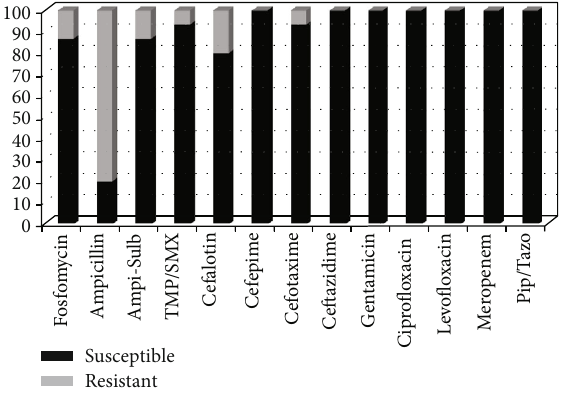
Figure 3: Percentage of Klebsiella pneumoniae isolates susceptible to antimicrobial drug. TMP/SMX: trimethoprim/sulfamethoxazole; Ampi-Sulb: ampicillin-sulbactam; Pip/Tazo: piperacillin-tazobactam.